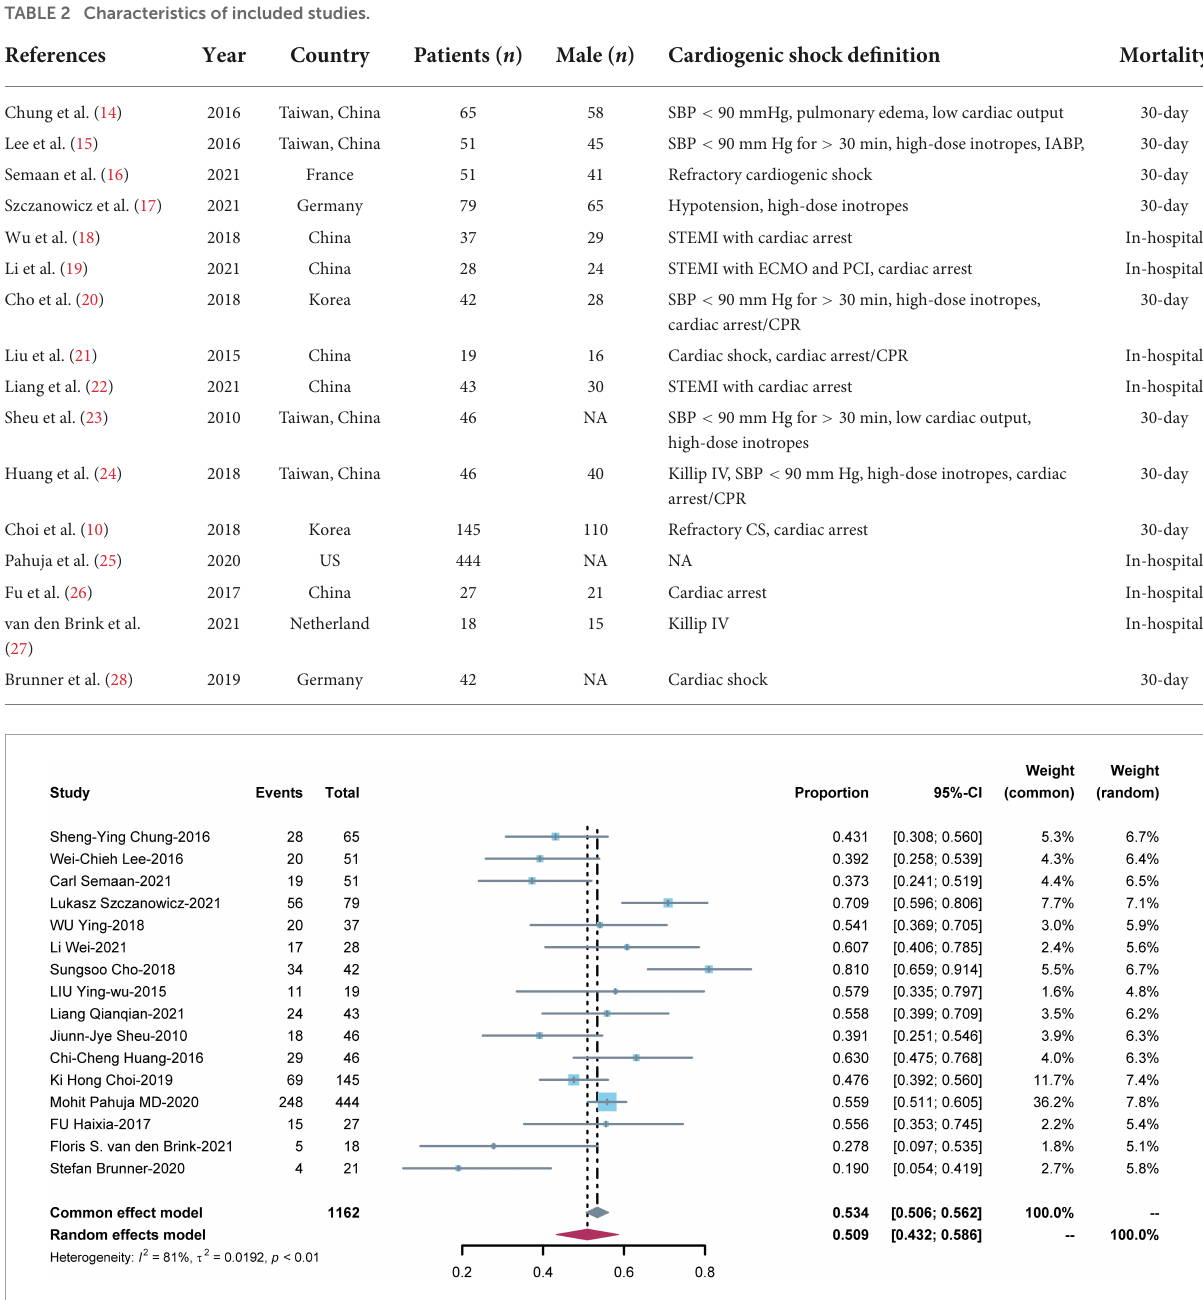
TABLE 2 Characteristics of included studies.